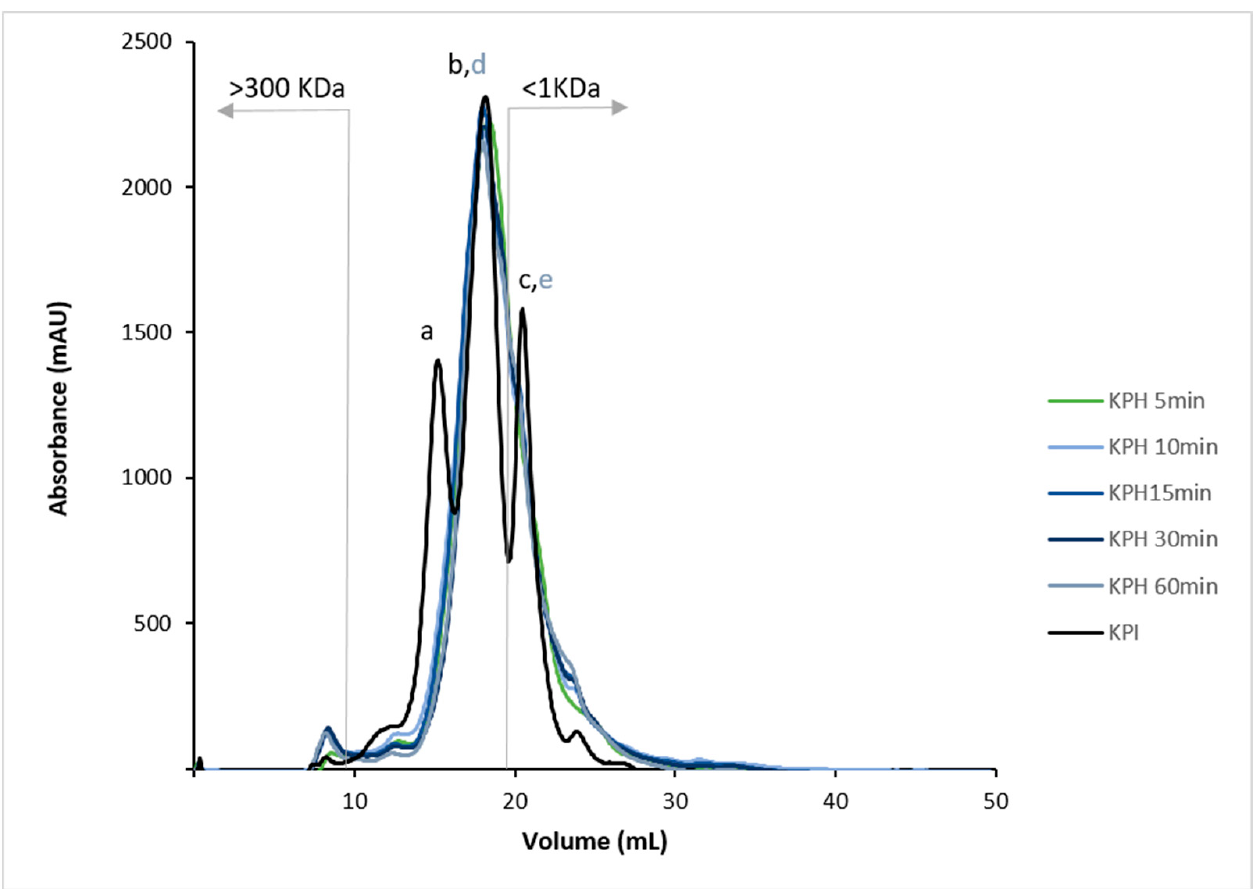
Figure 2. Molecular weight (MW) profiles by FPLC (size-exclusion) chromatogram of KPI and KPH5, KPH10, KPH15, KPH30, and KPH60. MW ranging from 1 to 300 kDa.